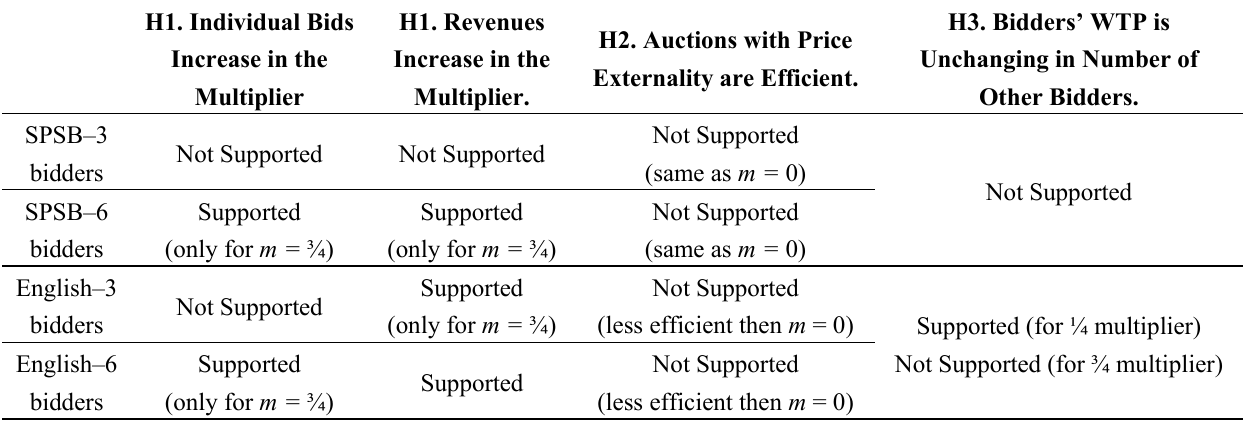
Table 4. Summary of Hypotheses tests for different